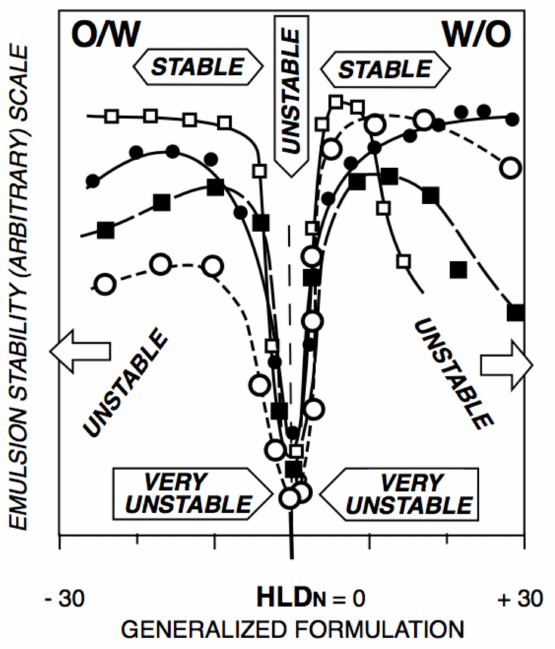
Figure 15. Systematic variations of emulsion stability with the HLD N with di ff erent